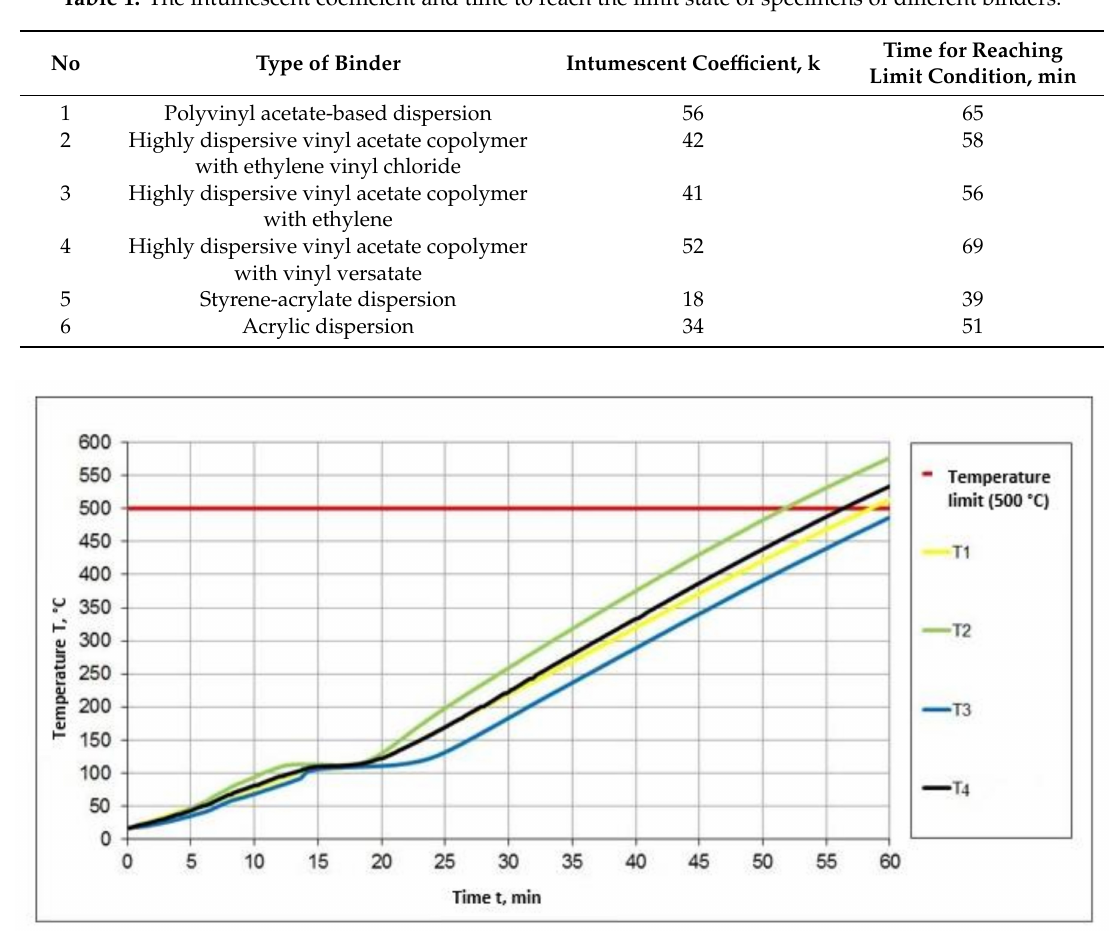
Table 1. The intumescent coe ffi cient and time to reach the limit state of specimens of di ff erent binders.